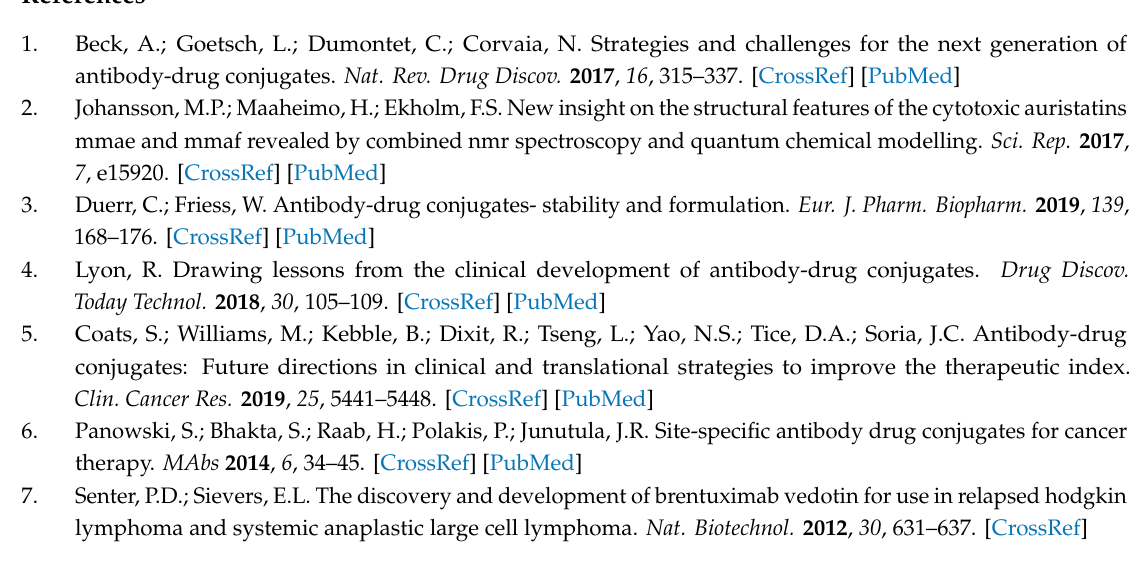
Figure S1: Structures of cleavable linker systems for current MMAE-based ADCs, Figure S2: Drug release study of the Cys-linker-MMAE-based ADC at the cellular level, Figure S3: Flow cytometry for apoptosis and cell cycle arrest analysis, Figures S4–S28: The original mass spectrometry and NMR spectra details of the synthesized compounds 4 – 15 . Table S1: Permeability prediction of MMAE and Cys-linker-MMAE